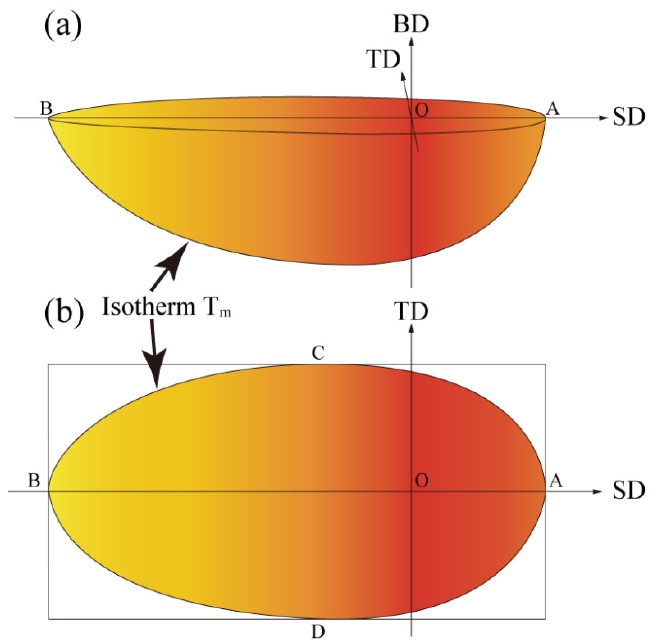
Figure 3. Schematic of the molten pool (SD, TD, BD refer to scanning, transverse, and build directions, respectively): ( a ) 3D diagram of the molten pool; ( b ) SD-TD cross-section of the molten pool.